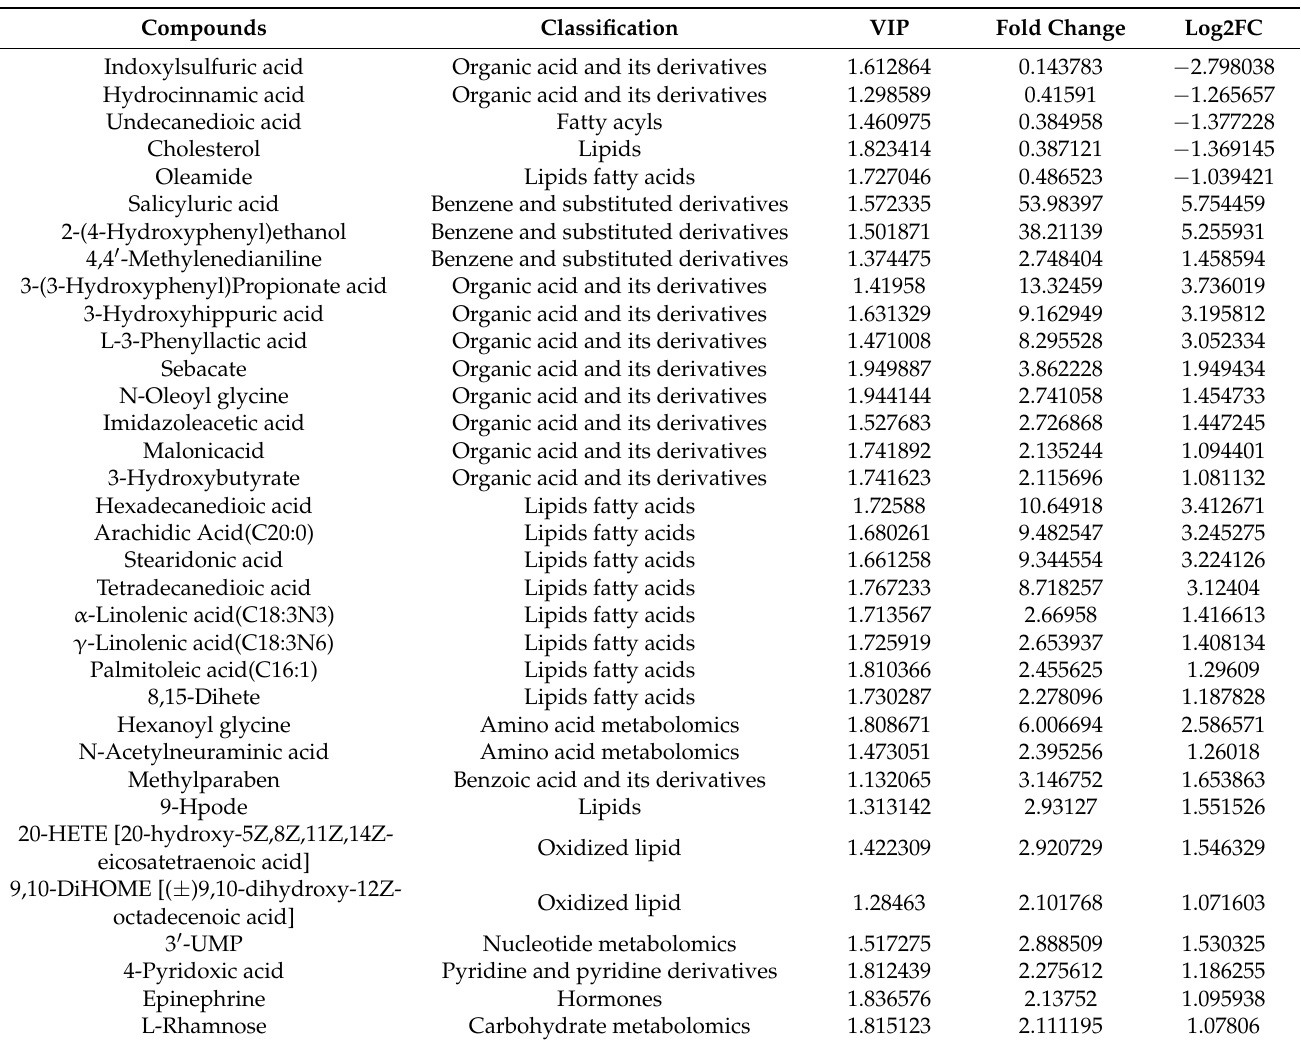
Table 4. Serum metabolites that differ significantly in the goat samples after feeding A. sinensis leaves using UPLC-MS/MS